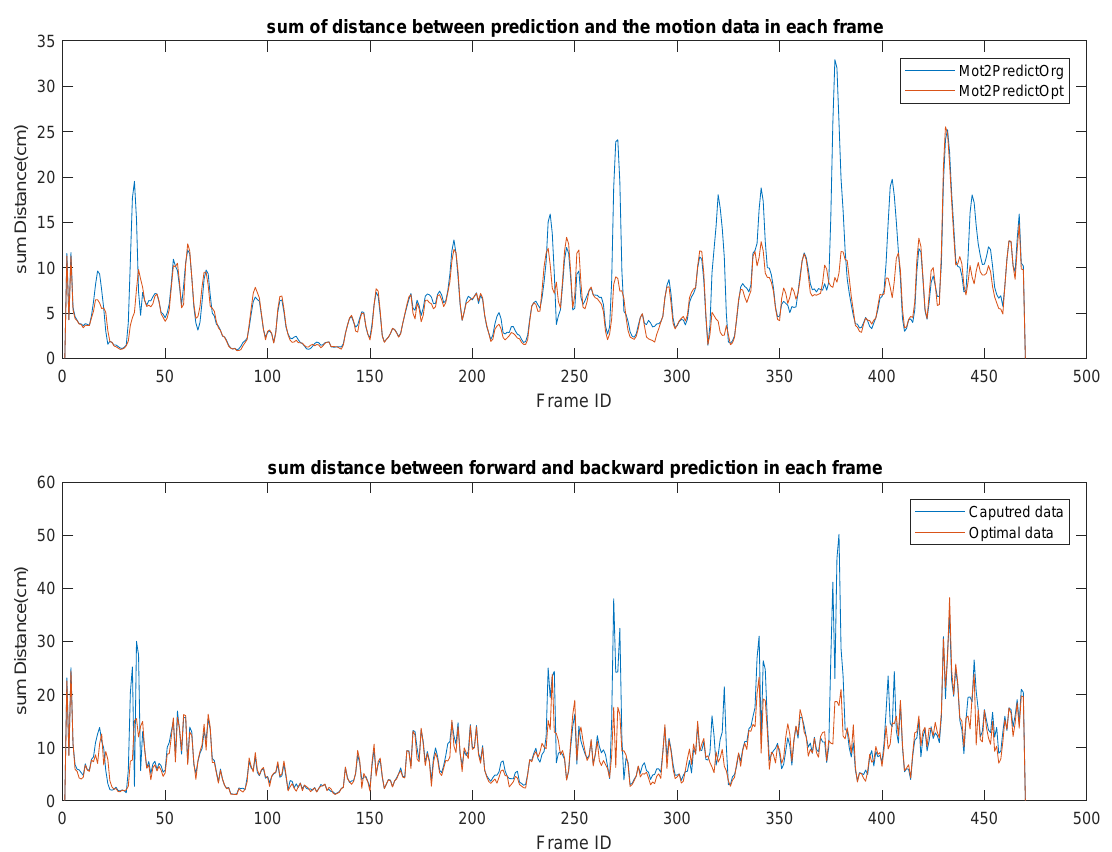
Figure 15. The summation of the bone length variance for each bone section over all frames. Purple: variance of the bone length captured with Nuitrack SDK for RealSense D435. Yellow: variance of the optimized bone length after applying our method.